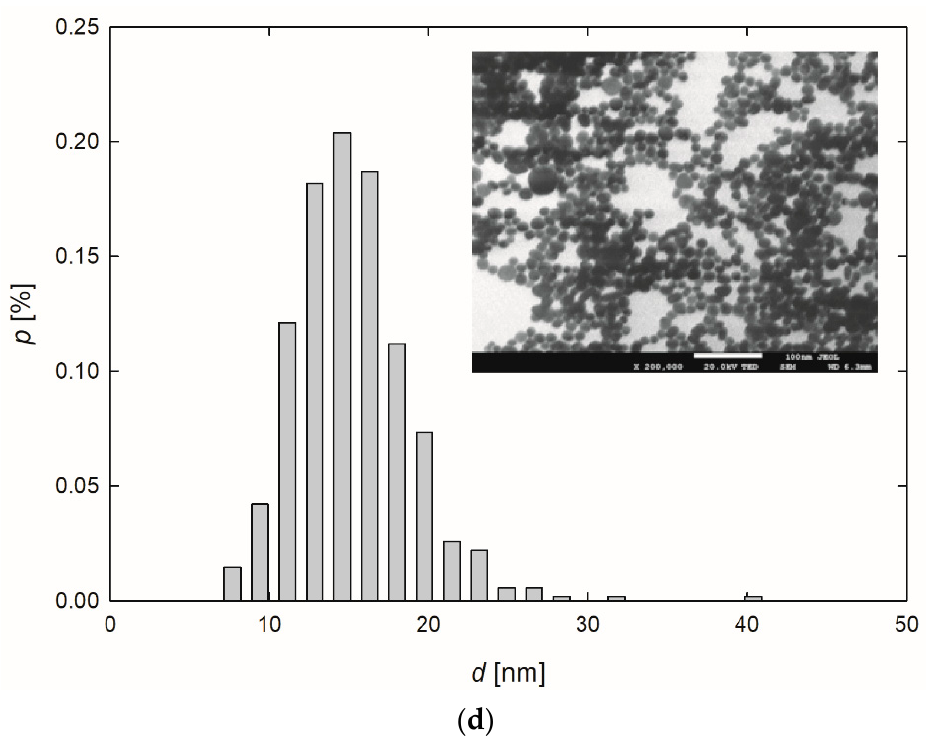
Figure 1. Extinction spectra ( a ) and the size distribution of AgNPs-TA ( b ), AgNPs-SBTC ( c ) and AgNPs-SHSH ( d ) with TEM micrographs (inserts).